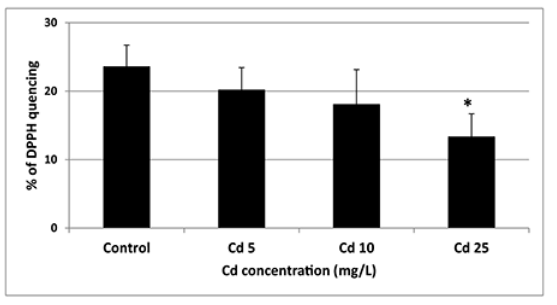
Figure 3 Antioxidant activity of seeds exposed to Cd at concentration 5 (Cd 5), 10 (Cd 10), and 25 (Cd 25) mg/L expressed as % of DPPH quenching. The results are means of five independent repetitions ± SE . Statistically significant differences ( p = 0.05) in relation to the control are marked with an asterisk (*).